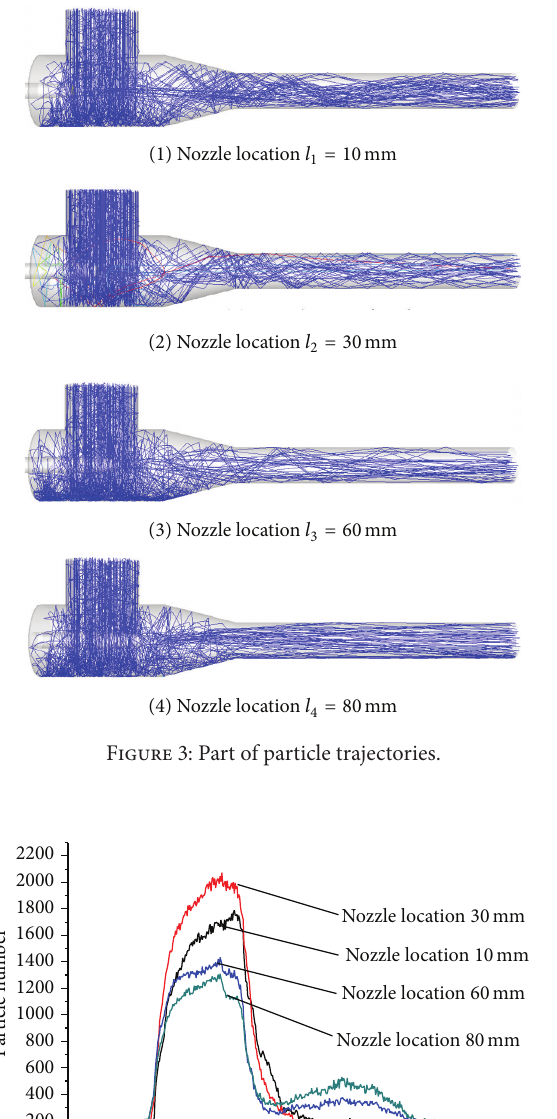
axis represents the simulation time and the vertical axis represents the remaining number of particles in the hopper.